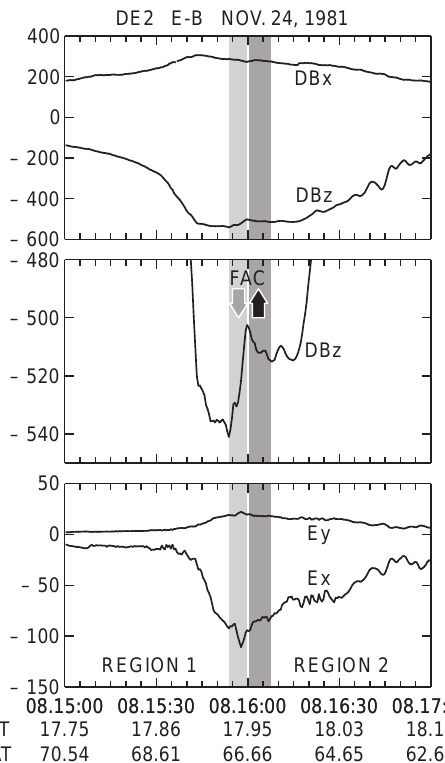
Fig. 6. DE-2 pass on November 24, 1981 at 0815–0817 UT: DB (southward) and DB (westward) components of the horizontal z magnetic field perturbation in spacecraft coordinates ( top ); zoom of the westward component DB ( middle ) horizontal components E z E of the electric field ( bottom ). (Courtesy J. King, NSSDC, through y NASA/NSSDC CDROM ‘‘DE-2 E&B’’ data). Between 0815:54 and 0816:07 UT the regions of upward FAC (presumably, an arc) and of adjacent downward FAC are